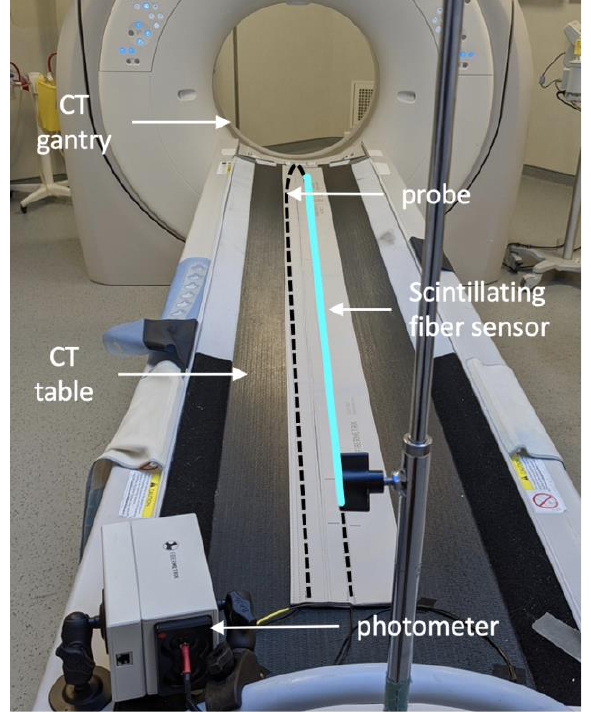
Figure 4. IVIscan system installed on a CT scan. The probe is placed on the CT table forming a U-shape at the head side of the table (black dotted line) and is connected to the photometer fixed at the feet side of the table. The scintillating fiber sensor (blue line) is placed in line to measure air kerma all along the exposure area on the CT table.